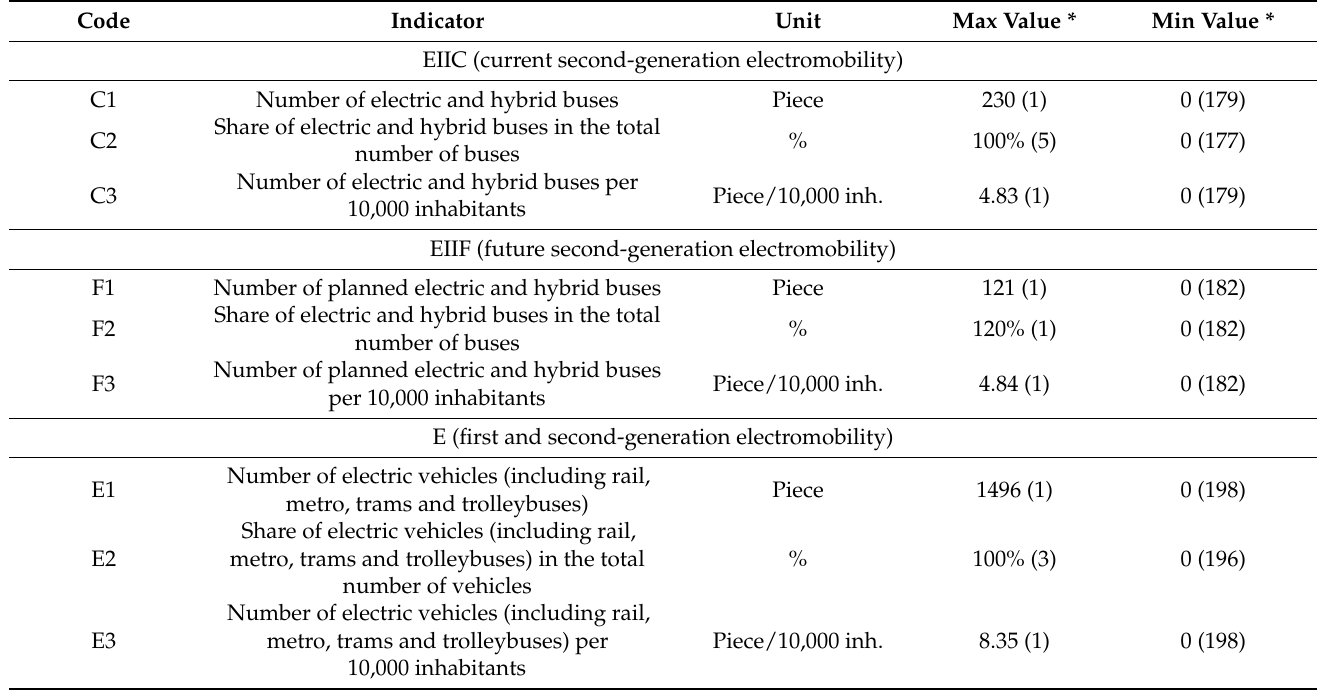
Table 3. Indicators used in the